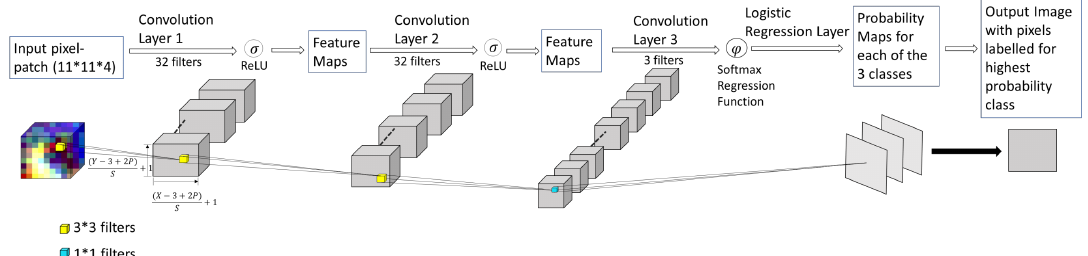
Figure 5. Overview of the proposed Fully Convolutional Neural Network architecture. The neural network consist of three convolutional layers. First two convolutional layers contain 32 filters each with size 3 × 3 each. The last layer replaces the fully connected layer with a convolutional layer containing three filters with size 1 × 1 and a softmax regression function to obtain class label probability for each